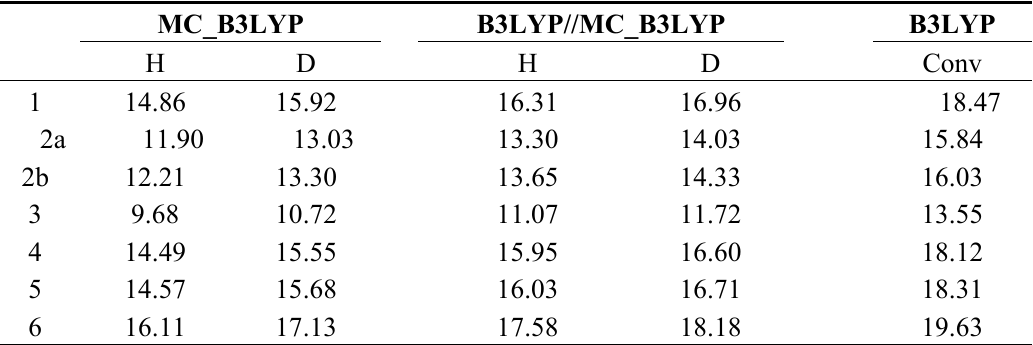
Table 3. Calculated nuclear magnetic shieldings (ppm) on hydrogen-bonded proton and deuteron in compounds 1 – 6